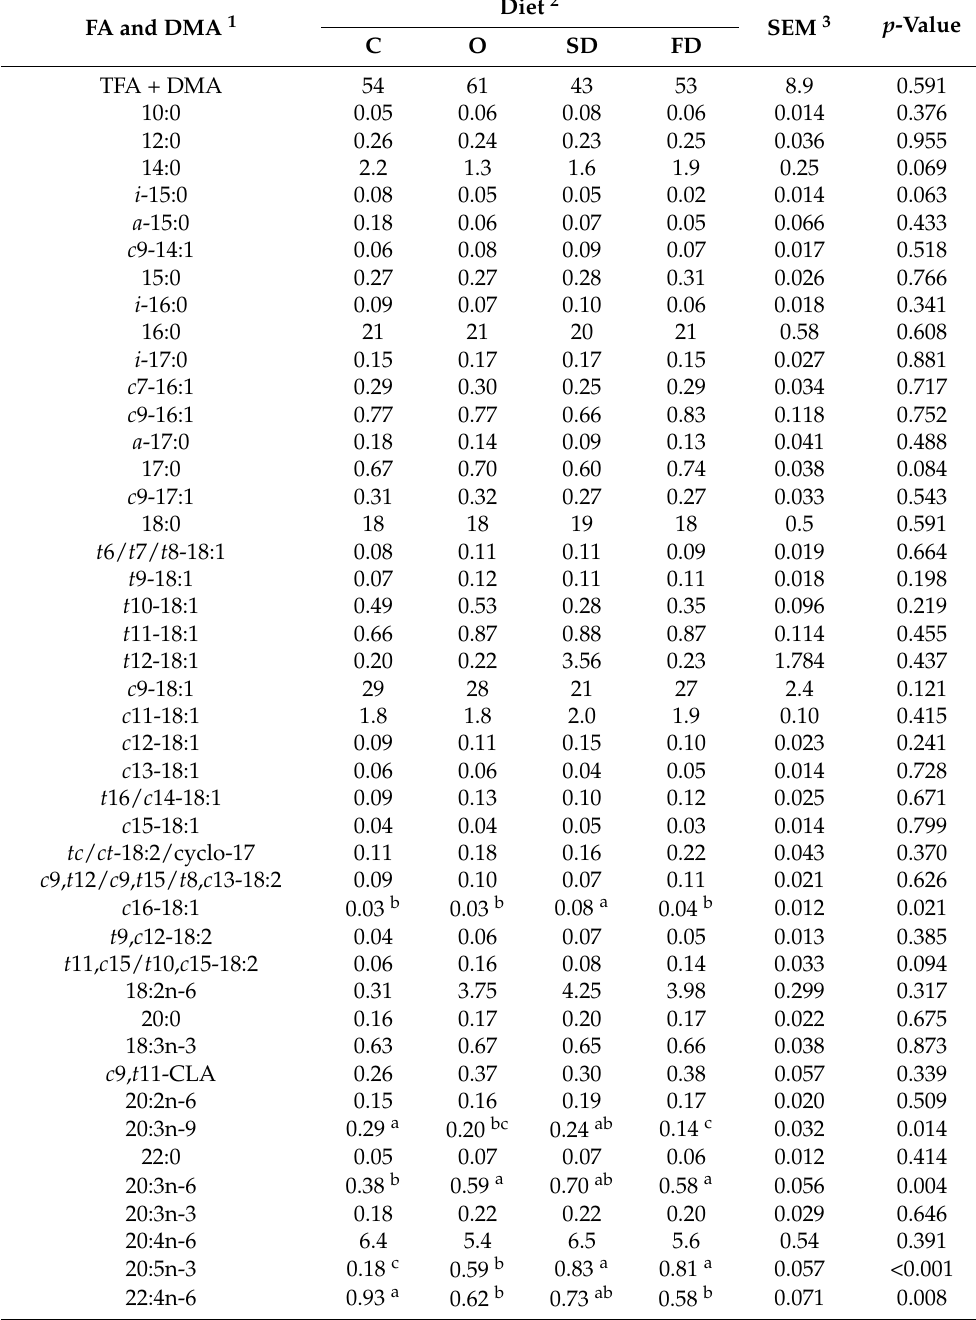
Table 5. Total fatty acid (TFA) and dimethyl acetal (DMA) (mg/g DM) content and composition (%TFA + DMA) of the RTL tissues of